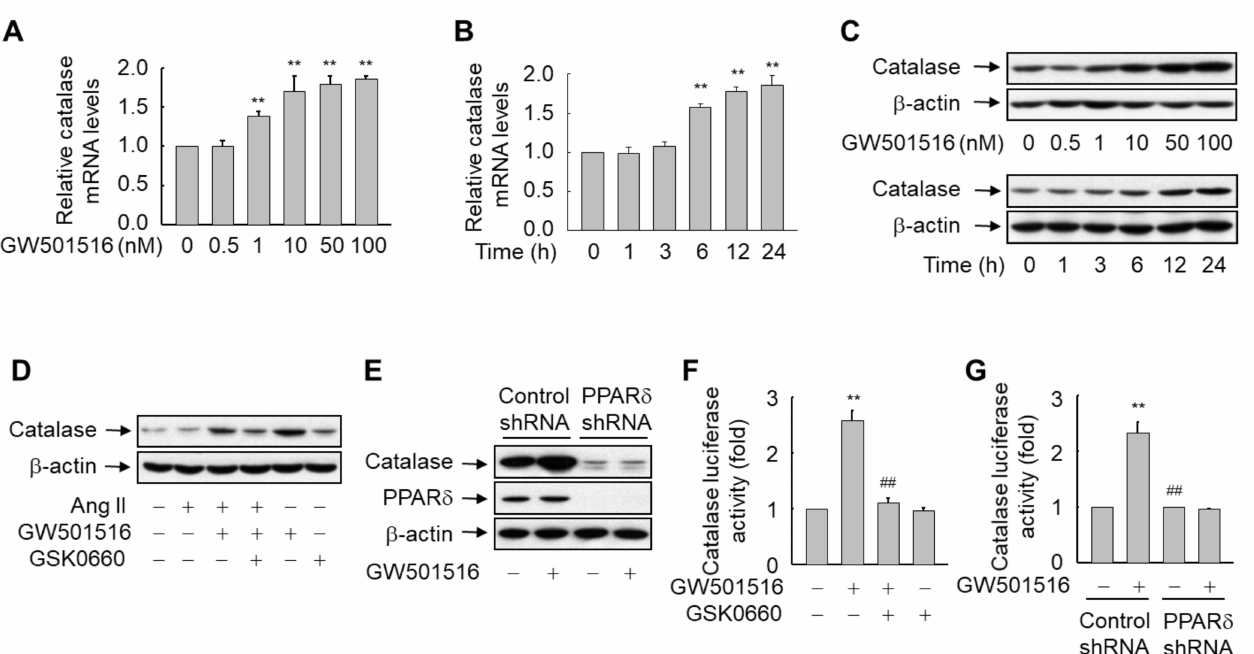
Figure 3. A PPAR δ ligand GW501516 upregulates the expression of catalase at both mRNA and protein levels in H9c2 cardiomyocytes. ( A – C ) Cells were incubated for 24 h with various concentrations of GW501516 ( A and upper panels of C ) or exposed to 100 nM GW501516 for the times indicated ( B and lower panels of C ). ( D ) Cells were pretreated with 100 nM GW501516 and/or 1 µ M GSK0660 for 12 h, and then exposed to 100 nM Ang II for 24 h. ( E ) Cells stably expressing PPAR δ shRNA or scrambled control shRNA were treated with or without 100 nM GW501516 for 24 h. Expression levels of catalase mRNA and protein were analyzed by real-time PCR ( A , B ) and Western blotting ( C – E ). ( F , G ) Cells pretreated with 1 µ M GSK0660 for 1 h ( F ) or stably expressing shRNA against PPAR δ or scrambled control sequences ( G ) were transfected with catalase luciferase reporter plasmid (1.5 µ g) and pSV- β -gal (0.5 µ g), and then exposed to 100 nM Ang II. After incubation for 24 h, cells were harvested, and cell lysates were subjected to reporter gene assays. Results are expressed as mean ± standard error (SE) of 3 to 4 independent experiments (** p < 0.01 compared with the untreated group; ## p < 0.01 compared with the Ang II-treated